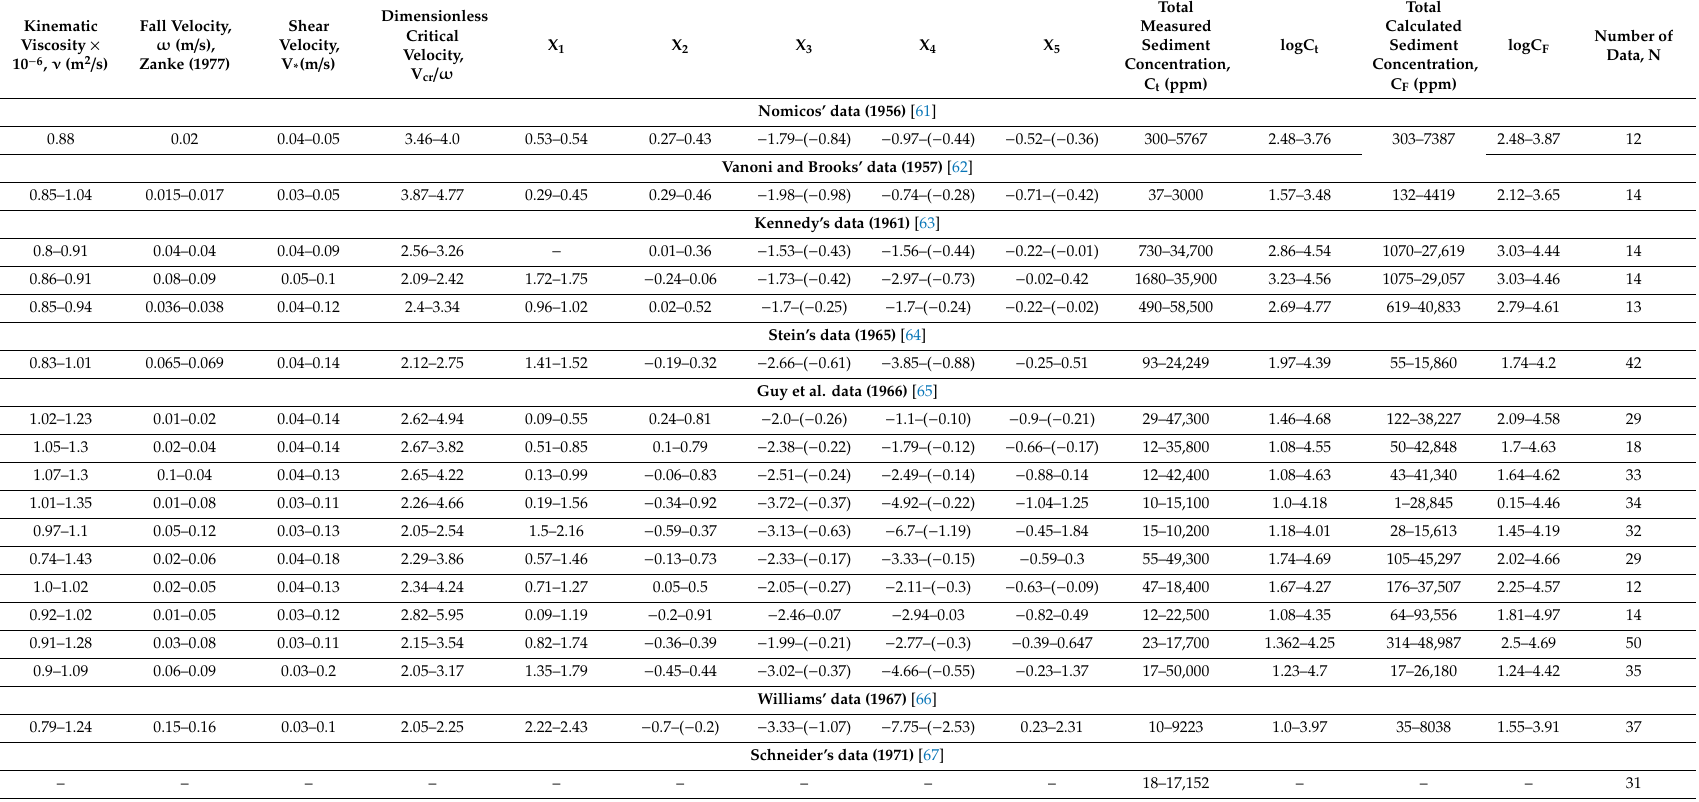
Table 2. Calculated parameters and variables for unit stream power